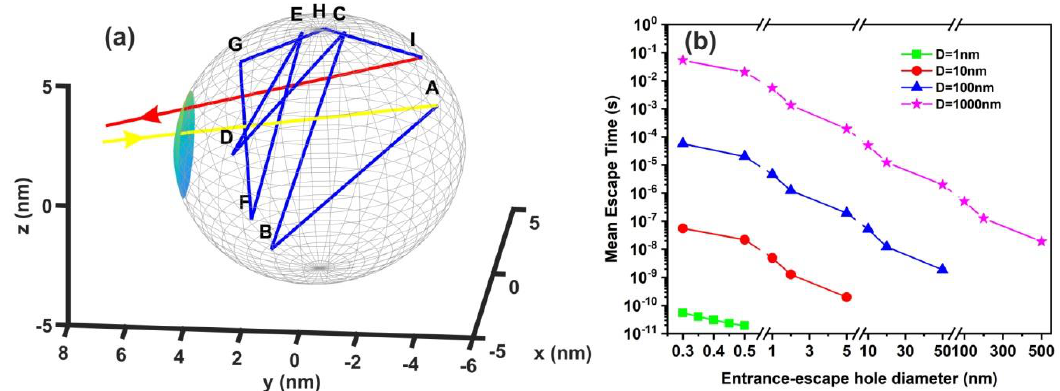
Figure 10. Non-interactive random walk of one water molecule in a nanocavity. ( a ) The water molecule enters the cavity (yellow arrow) and then it collides with the inside walls of the spherical cavity (10 nm) several times (A–I points and blue lines) before escaping from the entrance-escape hole (3 nm, red line); ( b ) mean escape time for 10 3 different random walk runs in 1 nm (green), 10 nm (red), 10 2 nm (blue), and 10 3 nm (magenta) spherical cavities for different entrance-escape hole diameters (0.3 nm–500 nm). The y-axis represents a logarithmic time scale.